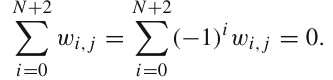
Fig. 2 Scheme of an exemplary artificial neural network used to repre- sent a single GPD. The example is for the truncation parameter N =